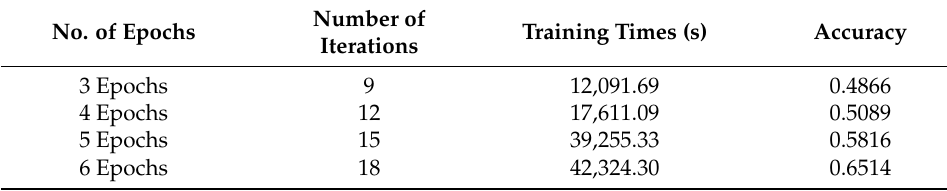
Table 5. MiniBatchsize training results for the value of 60.